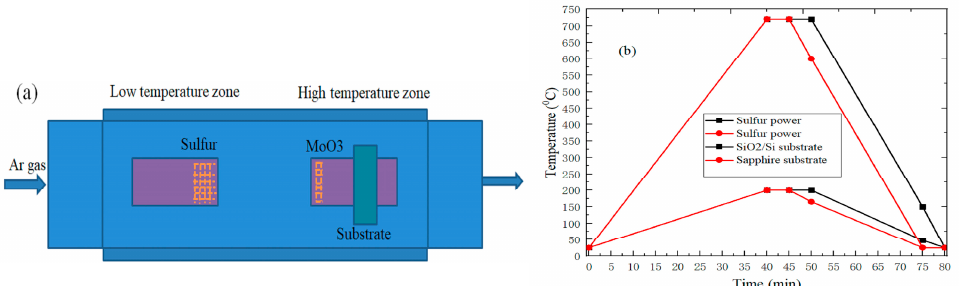
Figure 1. ( a ) The schematic diagram of MoS 2 growth; ( b ) The change curve of experimental temperature.